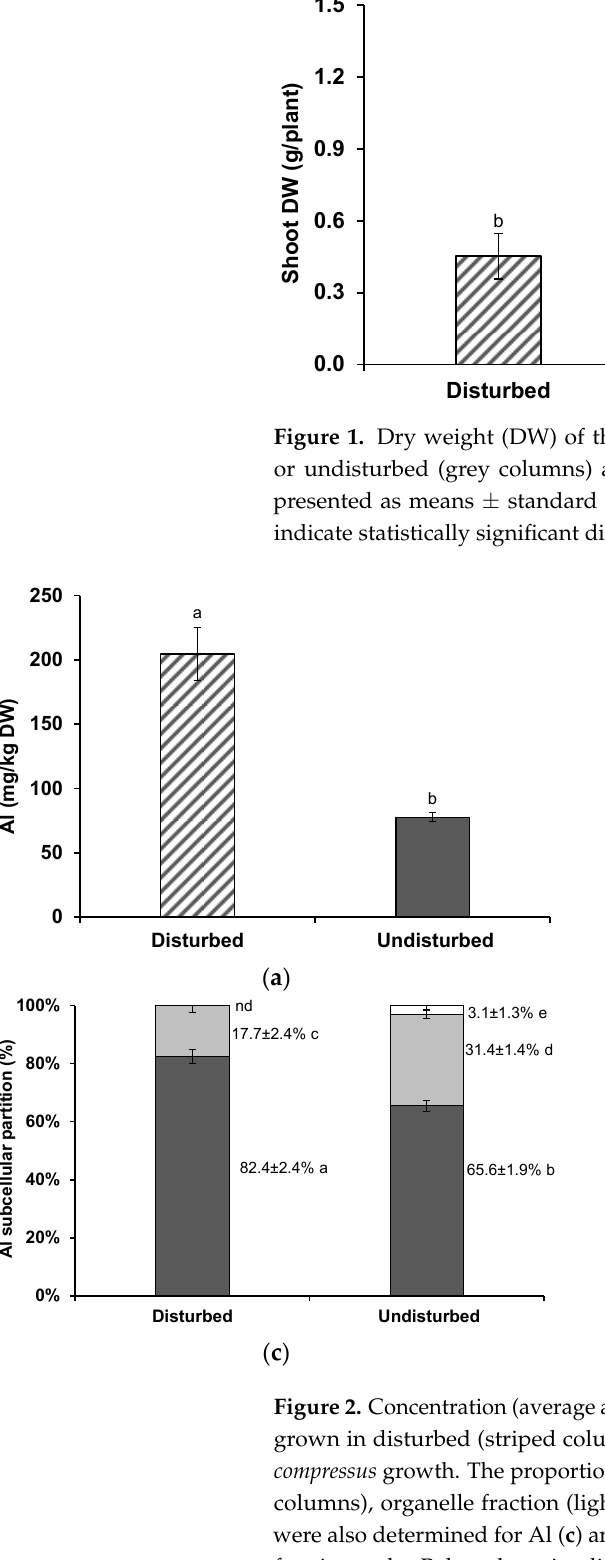
Figure 1. Dry weight (DW) of the shoots of wheat plants grown in disturbed (striped columns) or undisturbed (grey columns) acidic soil, after the growth of Ornithopus compressus . Data are presented as means ± standard error of four independent biological replicates. Different letters indicate statistically significant differences ( p < 0.05).